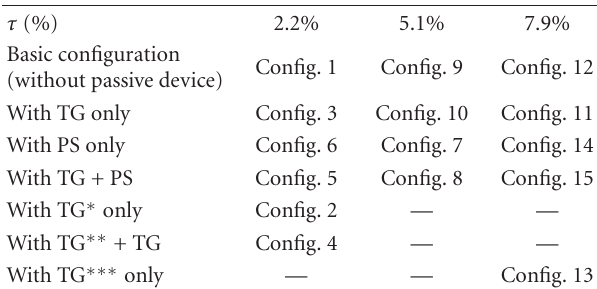
Table 1: Design details of the rotor. Table 2: Configurations